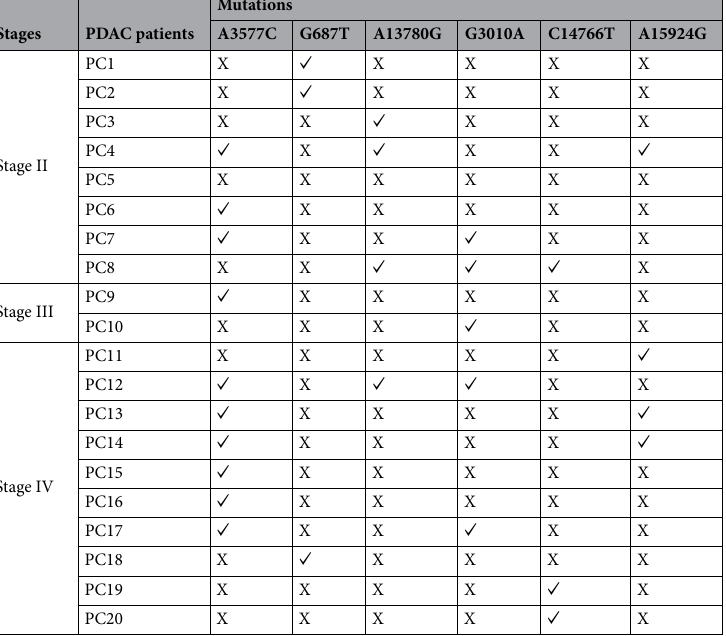
Table 2. MtDNA mutations covering all PDAC subjects. ✓ , Mutation present; X, mutation absent. A3577C: